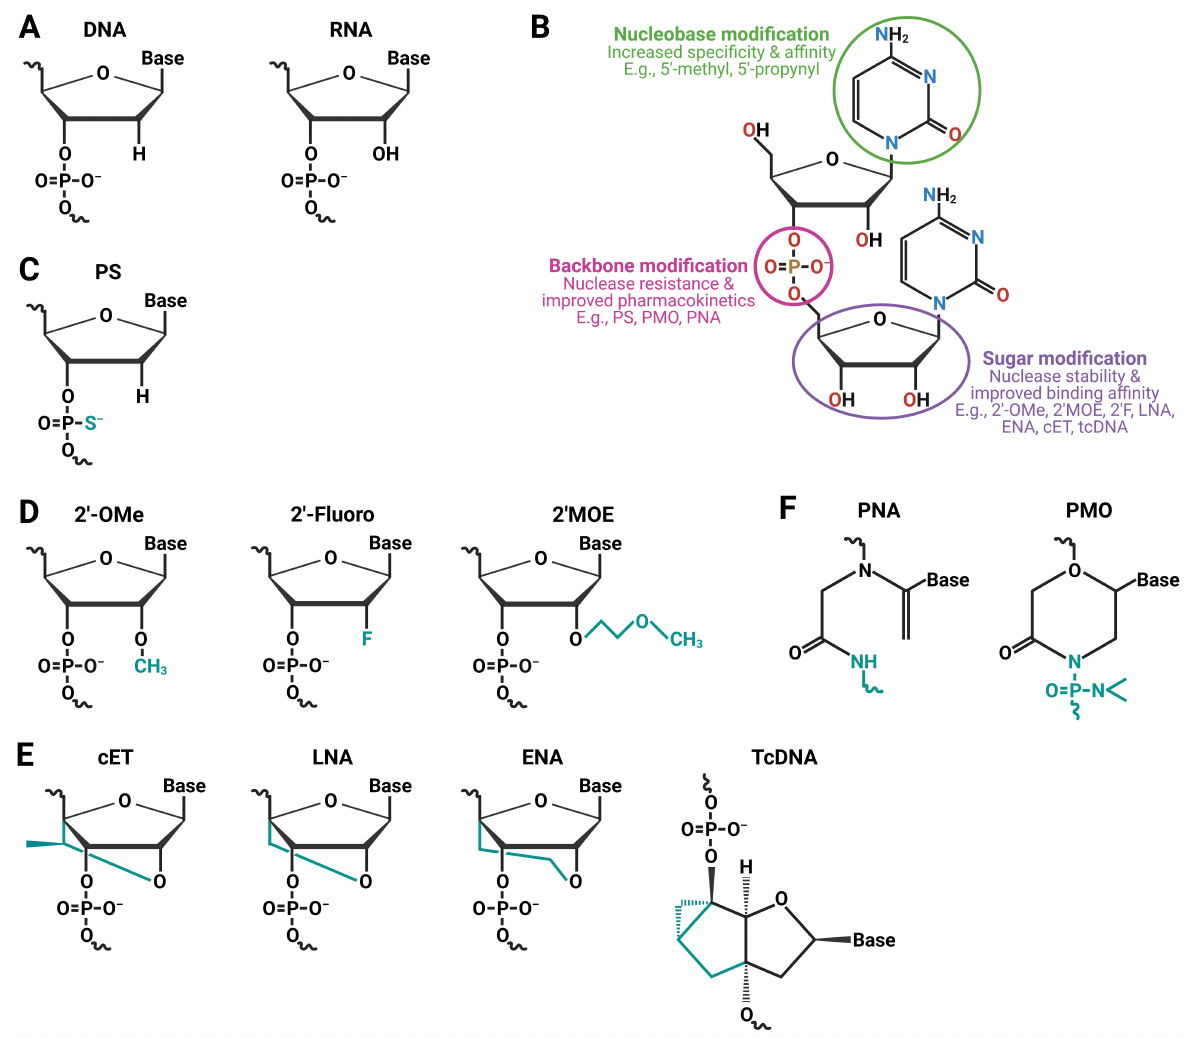
Figure 3. This is a wide figure. Figure 2. Some commonly used ON chemistries. ( A ) DNA and RNA are two naturally occurring nucleotides. ( B ) Common modification sites on a nucleotide. ( C ) The phosphorothioate (PS) backbone replaces the natural phosphodiester (PO) bond in naturally occurring nucleotides. This enhances the affinity of PS for binding to serum proteins, which helps it evade degradation, causes RNase H to cleave the target RNA, and prevents it from being rapidly excreted by the kidneys [18,23,24]. The structural formula shows a PS-modified DNA monomer. ( D ) The most frequent modifications to ribose at the 2 (cid:48) -O positions of RNA and DNA are 2 (cid:48) -O-methyl (2 (cid:48) -OMe), 2 (cid:48) -O-methoxyethyl (2 (cid:48) MOE), and 2 (cid:48) -fluoro (2 (cid:48) -F). Similar to PS, these changes aid in protecting it from nuclease degradation. These modifications boost the thermal stability of the hybrid that the ON is going to make, thus providing the opportunity to use shorter ONs. However, due to their strong resemblance to RNA rather than DNA, these cannot undergo RNase H cleavage [23]. ( E ) Constrained 2 (cid:48) -O-ethyl (cEt), locked nucleic acid (LNA), 2 (cid:48) -O,4 (cid:48) -C-ethylene-bridged nucleic acids (ENA), and tricyclo DNA (tcDNA) are conformationally constrained analogues to DNA created by putting in a methyl bridge from the 2 (cid:48) -O to 4 (cid:48) positions of the ribose sugar. These modify the overall charge of the nucleotide and provide flexibility [14,25–27]. ( F ) Peptide nucleic acids (PNAs) and phosphorodiamidate morpholino oligomers (PMOs) are charge-neutral nucleotides, the results of nucleobase modifications [28]. PMO has morpholine rings as its backbone joined by phosphorodiamidate linkages; the ribose ring is opened by oxidation then re-closed using ammonia to form a substituted morpholine moiety with phosphorodiamidate linkages substituting phosphodiester bonds. ( C – F ) The cyan color shows the modifications made (Created with BioRender: